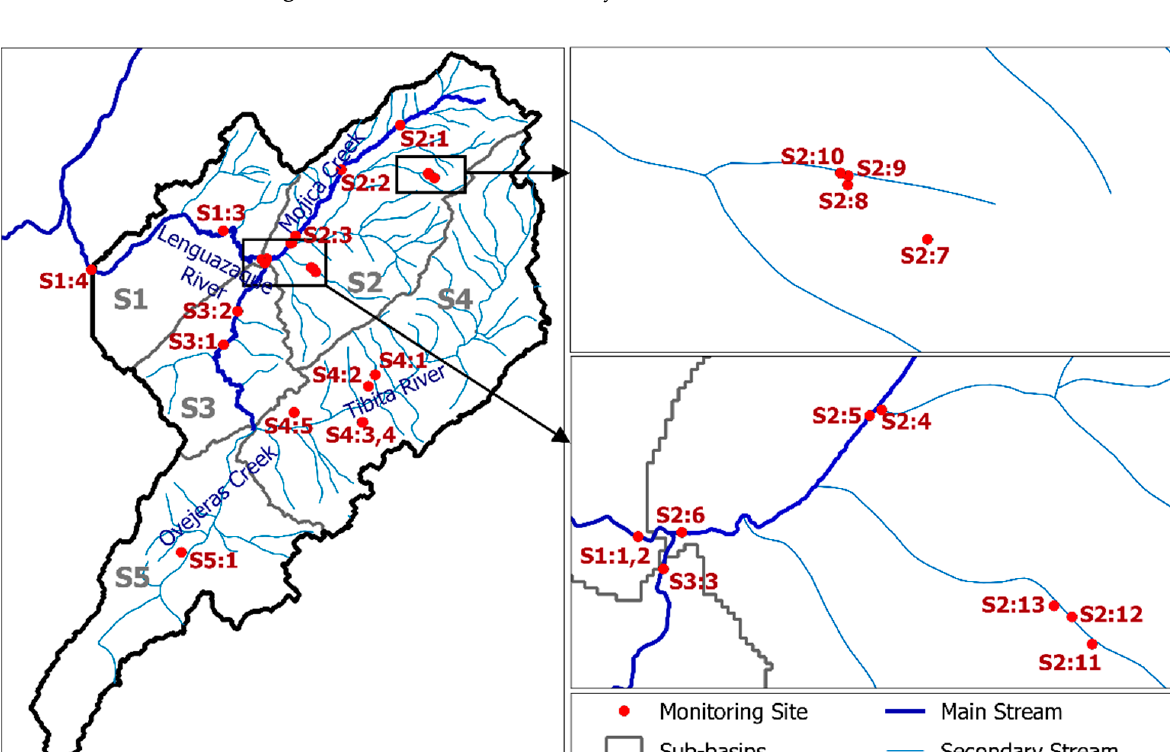
Figure 2. Location of sub-basins and monitoring sites.